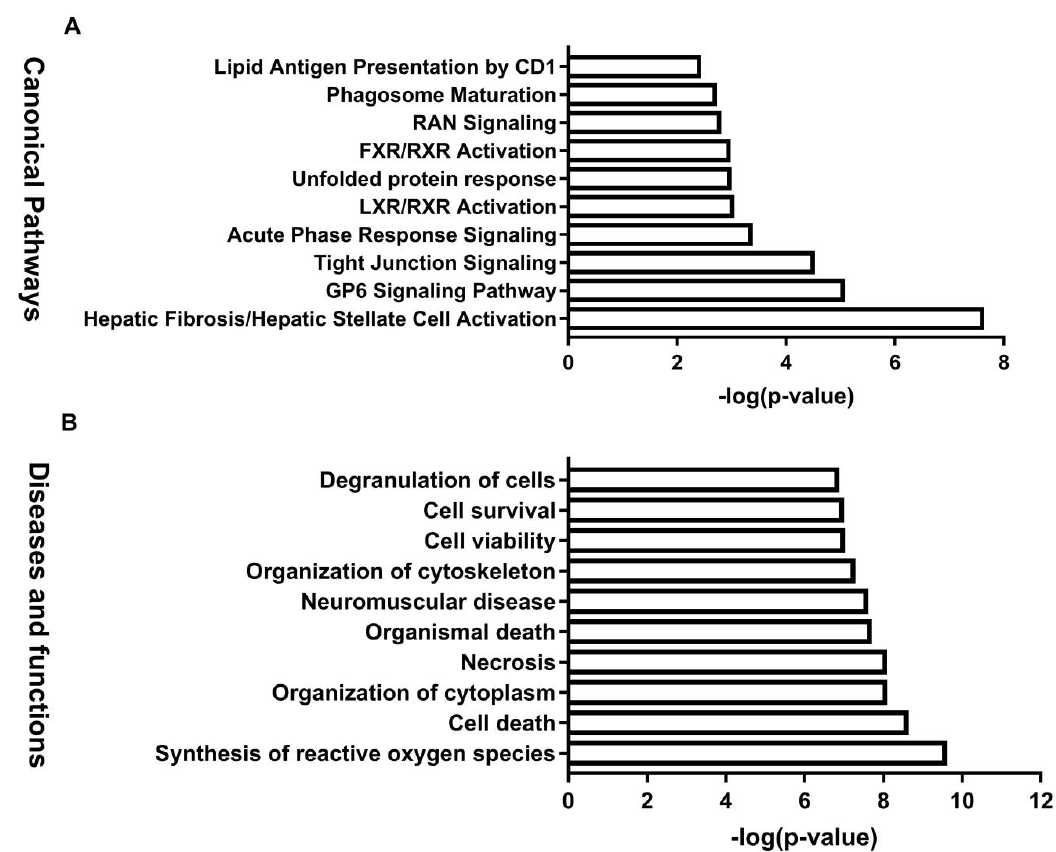
Figure 6. Canonical pathways, and diseases and functions analysis of the differentially expressed protein and metabolites. ( A ): Canonical pathway enrichment analysis for sets of the differentially expressed genes. ( B ): Diseases and functions enrichment analysis. p values < 0.05 and an FDR value < 0.05 were selected as the significant criteria. It seems that Alu and Clu were the key regulators in this network (Figure 7B), which may indicate their critical roles in BDE-47-induced male reproductive toxicity. The ex- pression of MYC and Clu was verified via quantitative real-time PCR (Figure 7C,D).